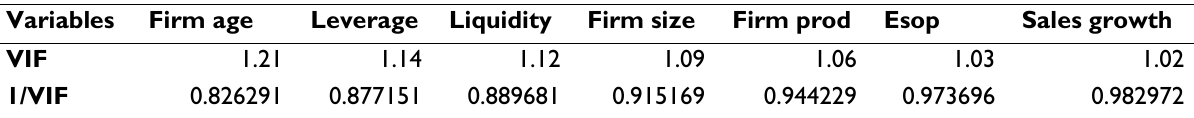
Table 3 VIF for Multicollinearity Test